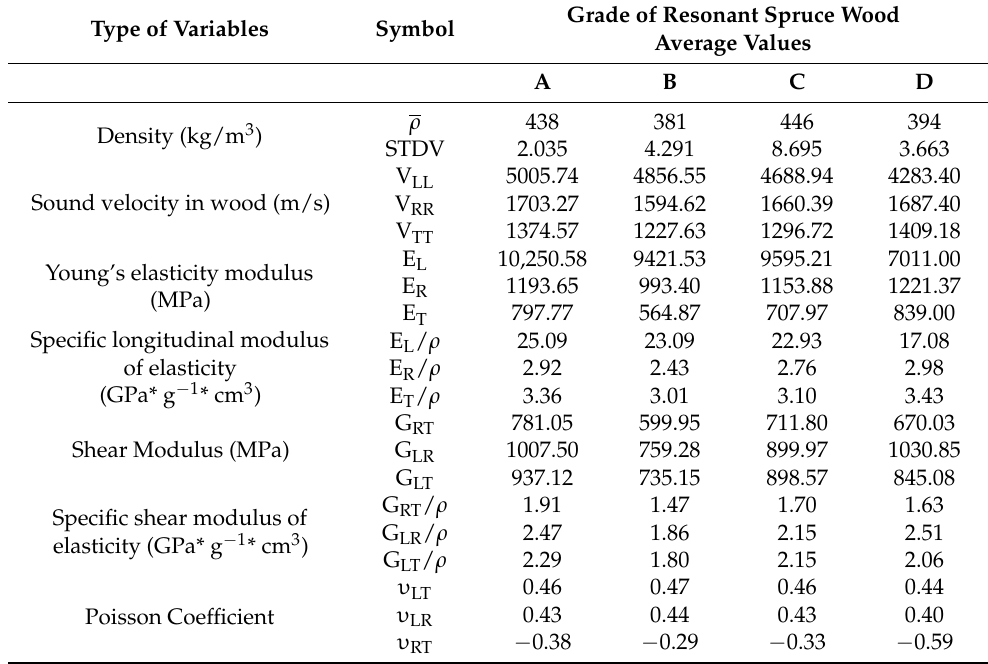
Table 5. The acoustic and elastic parameters.